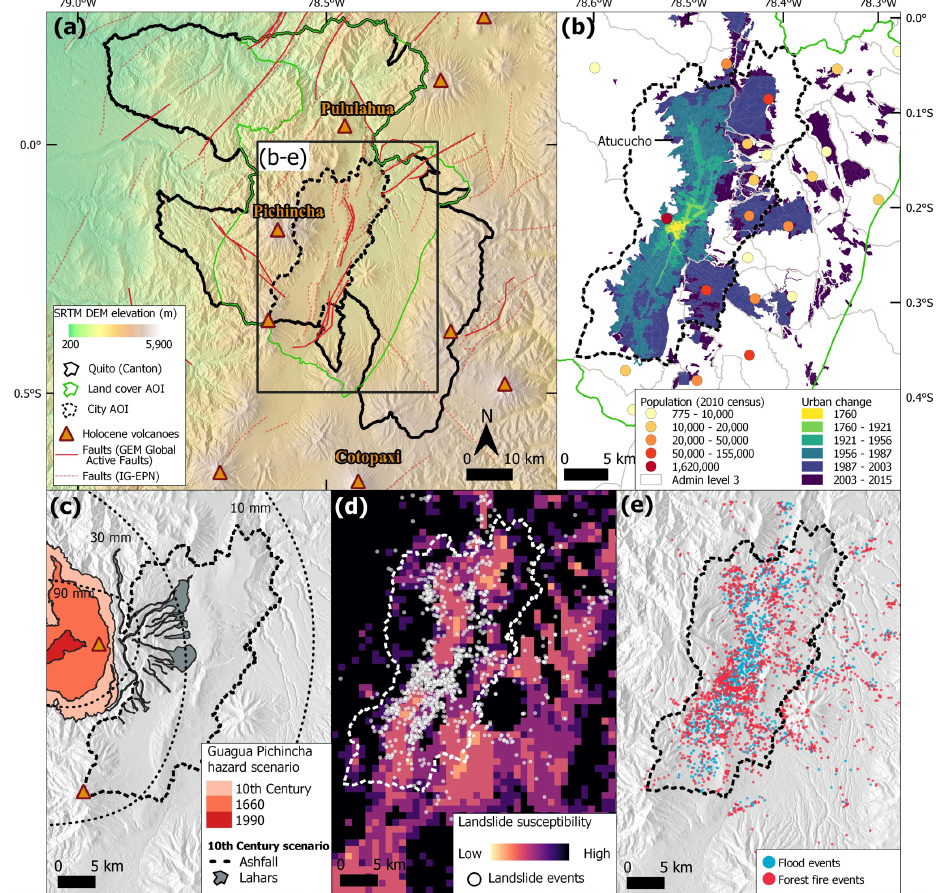
Figure 2. (a) The location of Quito, Ecuador, in relation to regional seismic faults and volcanoes. Fault lines (red) are from the Geophysical Institute of the National Polytechnic School (IG-EPN) and Global Earthquake Model Global Active Faults (Styron, 2019). (b) Urban change and population of Quito are mapped using Open Government data (https://datosabiertos.gob.ec/, last access: 16 May 2022). (c) Volcanic hazards from the IG-EPN et al. (2019) Pichincha Volcano hazard map. (d) Landslide susceptibility map (Stanley and Kirschbaum, 2017) and observed landslide events ( n = 1321) (2006–2017) (https://datosabiertos.gob.ec/, last access: 16 May 2022). (e) Observed hydrometeorolog- ical ( n = 1574) and forest fire events ( n = 2358) (2006–2017) (https://datosabiertos.gob.ec/, last access: 16 May